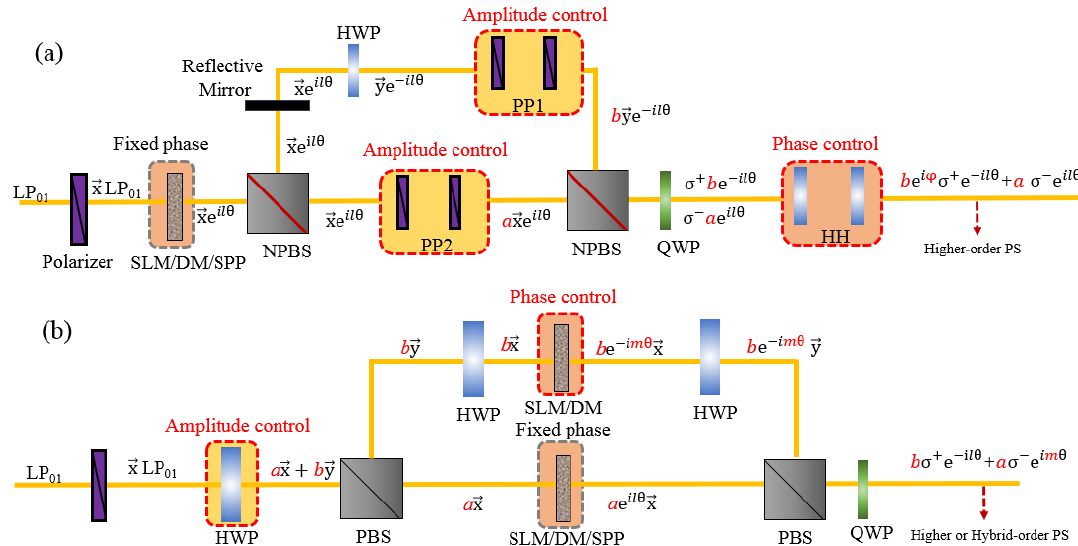
Figure 7. The flow chart of tunable OAM generation by interfering with two Laguerre-Gaussian modes. Adjusting phase and amplitude factors of two branches by ( a ) optical elements and ( b ) a HWP and a SLM.